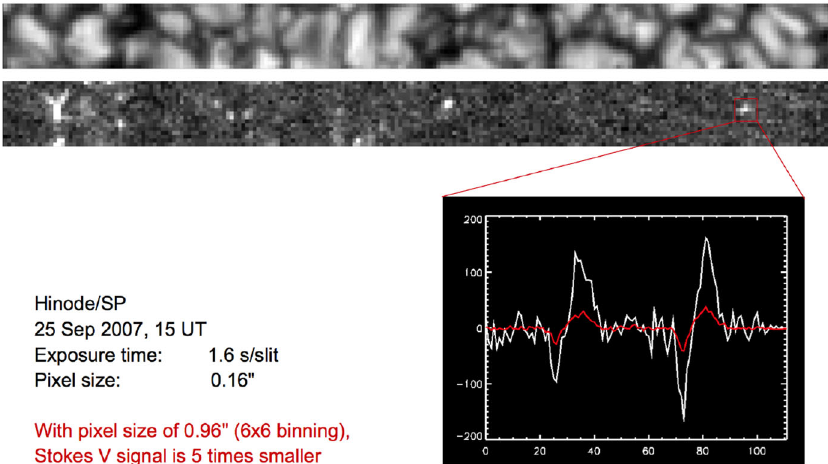
Fig. 7 Hinode/SP observations showing that higher spatial resolution often leads to stronger polarization signals. The Stokes V profile from the central pixel of a quiet Sun magnetic patch at original resolution (0 . 16 (cid:2)(cid:2) per pixel, white curve) is about 5 times larger than that observed at degraded resolution (0 . 96 (cid:2)(cid:2) per pixel, red